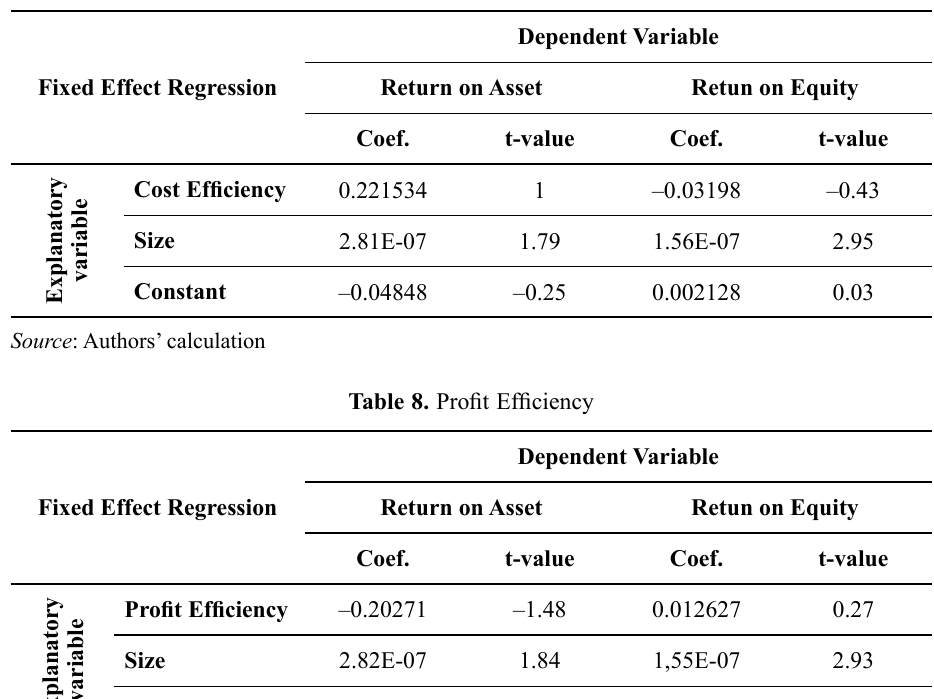
Table 7. Cost Efficiency